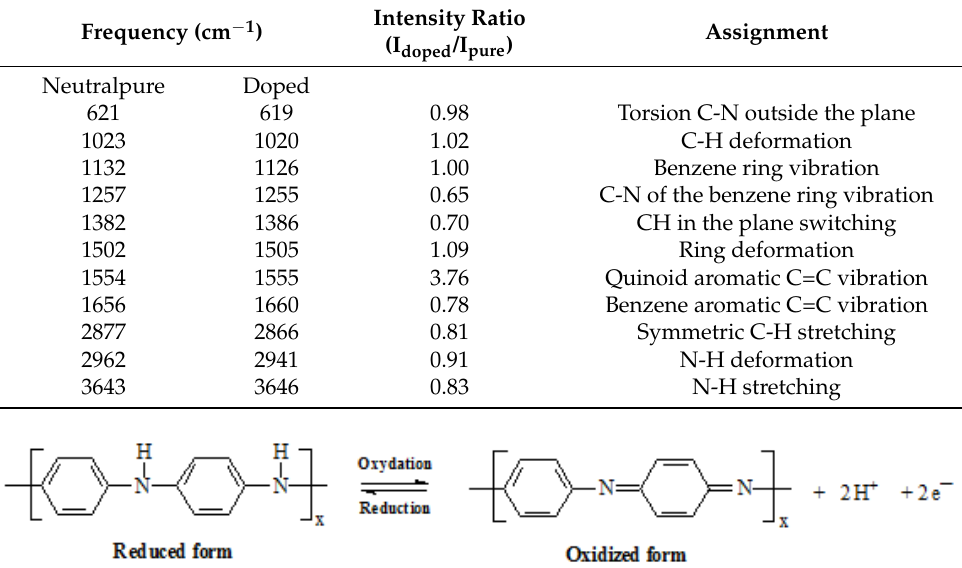
Scheme 1. Mechanism of acid doping of the leucomeraldine base form: transformation to the oxidized form (EB). Table 1. FTIR vibrational modes of PANI in both pure and doped states.